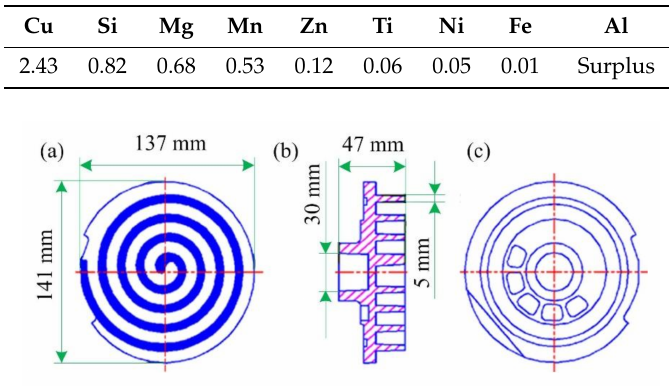
Figure 1. Structure and dimensions of the scroll for scroll compressors applied in automotive air conditioning: ( a ) front view, ( b ) sectional view, and ( c ) back view.